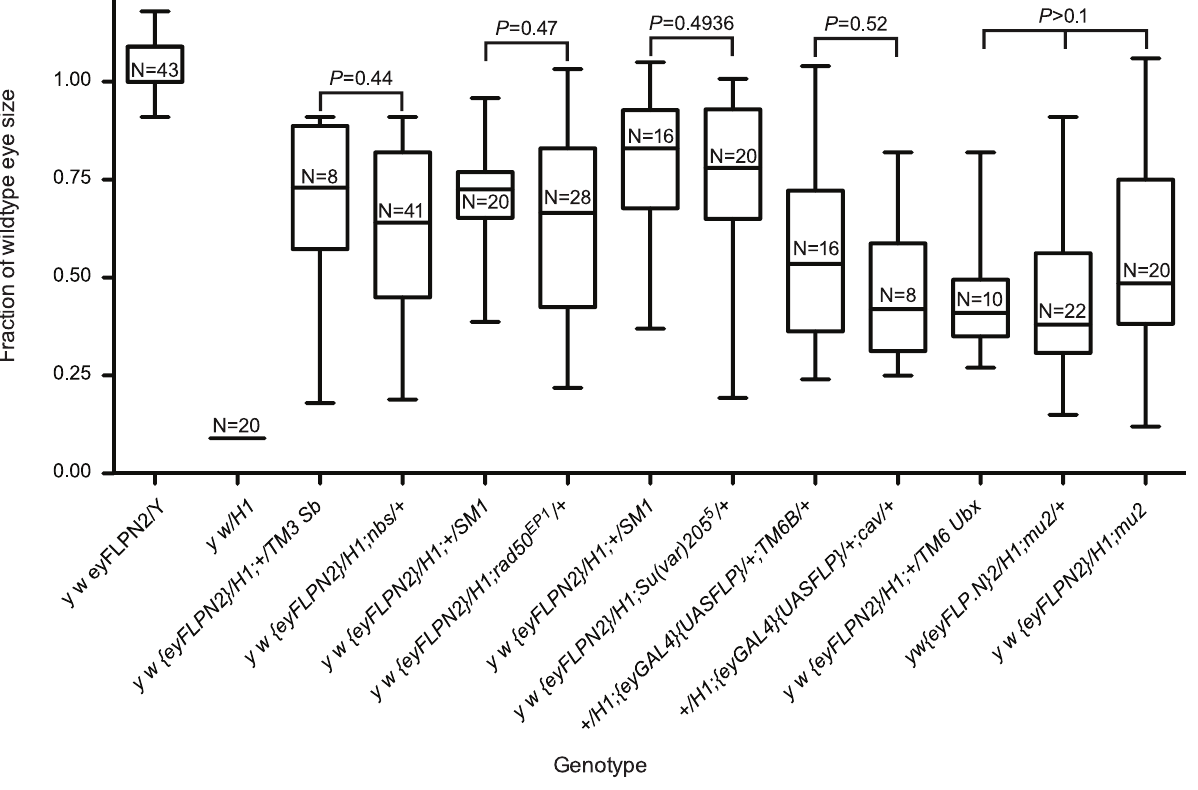
Figure 6. The role of genes required for telomere protection in cell survival after telomere loss. The first two whisker plots are controls and are repeated here (from Figure 2) for ease of comparison. All sizes are presented after normalization to wild type. Statistical comparisons were performed between genotypes produced from the same cross to minimize possible background effects (except a different cross was used to generate mu2 homozygotes). Significance levels for critical comparisons are indicated.